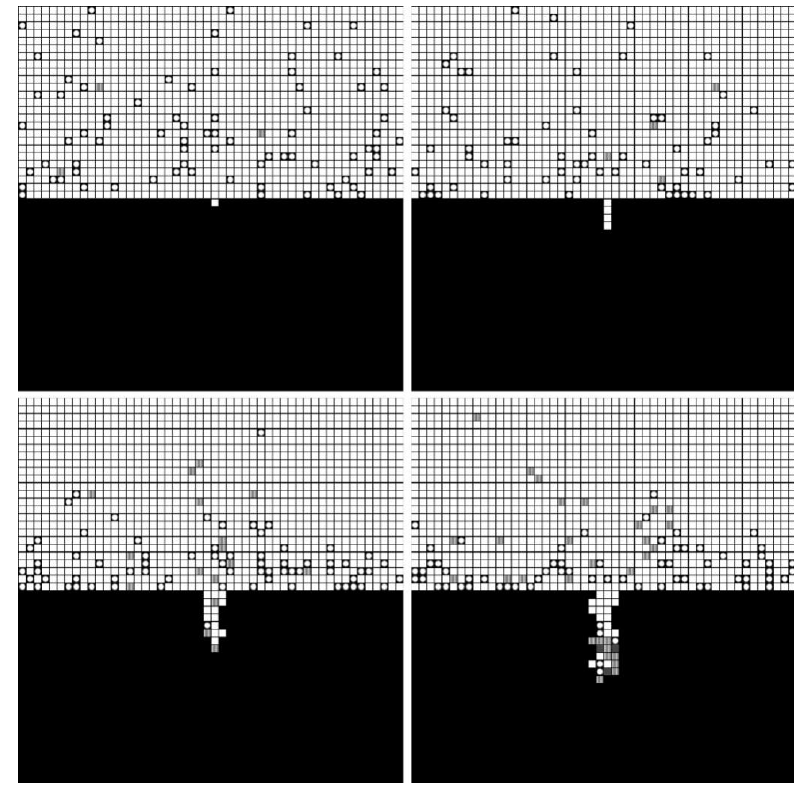
Figure 4. Simulation results under 4 V.